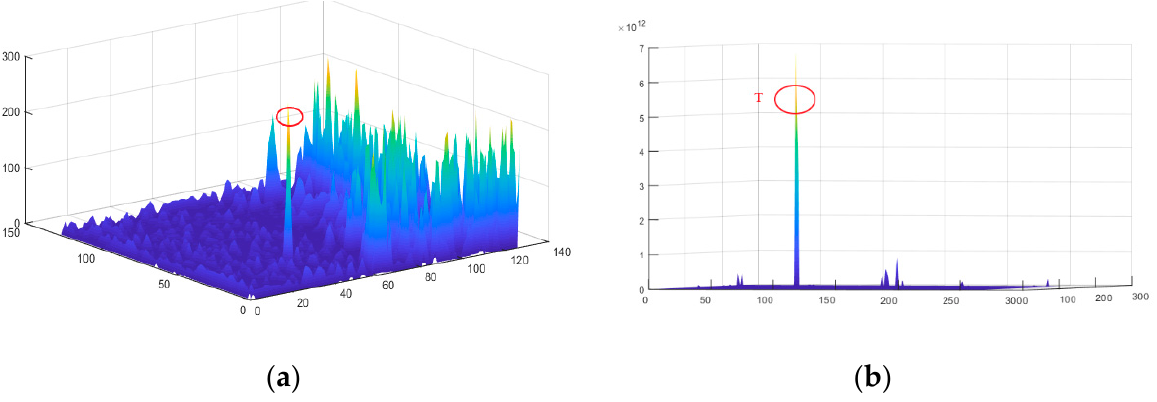
Figure 5. 3-D surface. ( a ) 3D diagram of the intensity of the preprocessing results map. ( b ) 3D diagram of the intensity of the FSM map.